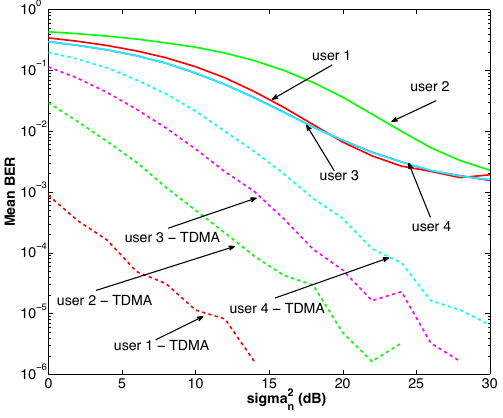
Figure 4. BER Performance of every user